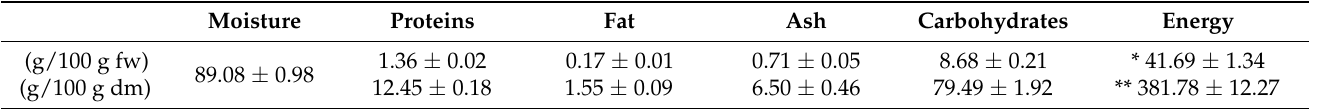
Table 1. Proximate analysis of P. eryngii fruiting